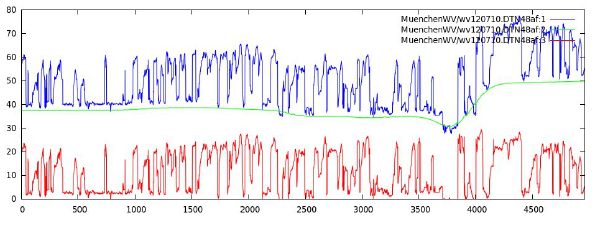
Figure 5. Profile from left top to right bottom in fig. 4, blue: height map, green: ground, red: normalized DEM, height map and ground with an offset of − 520